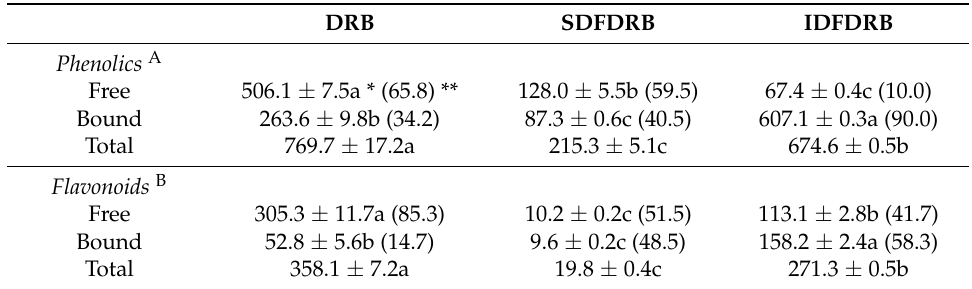
Table 1. Phenolic and flavonoid contents of defatted rice bran and its dietary